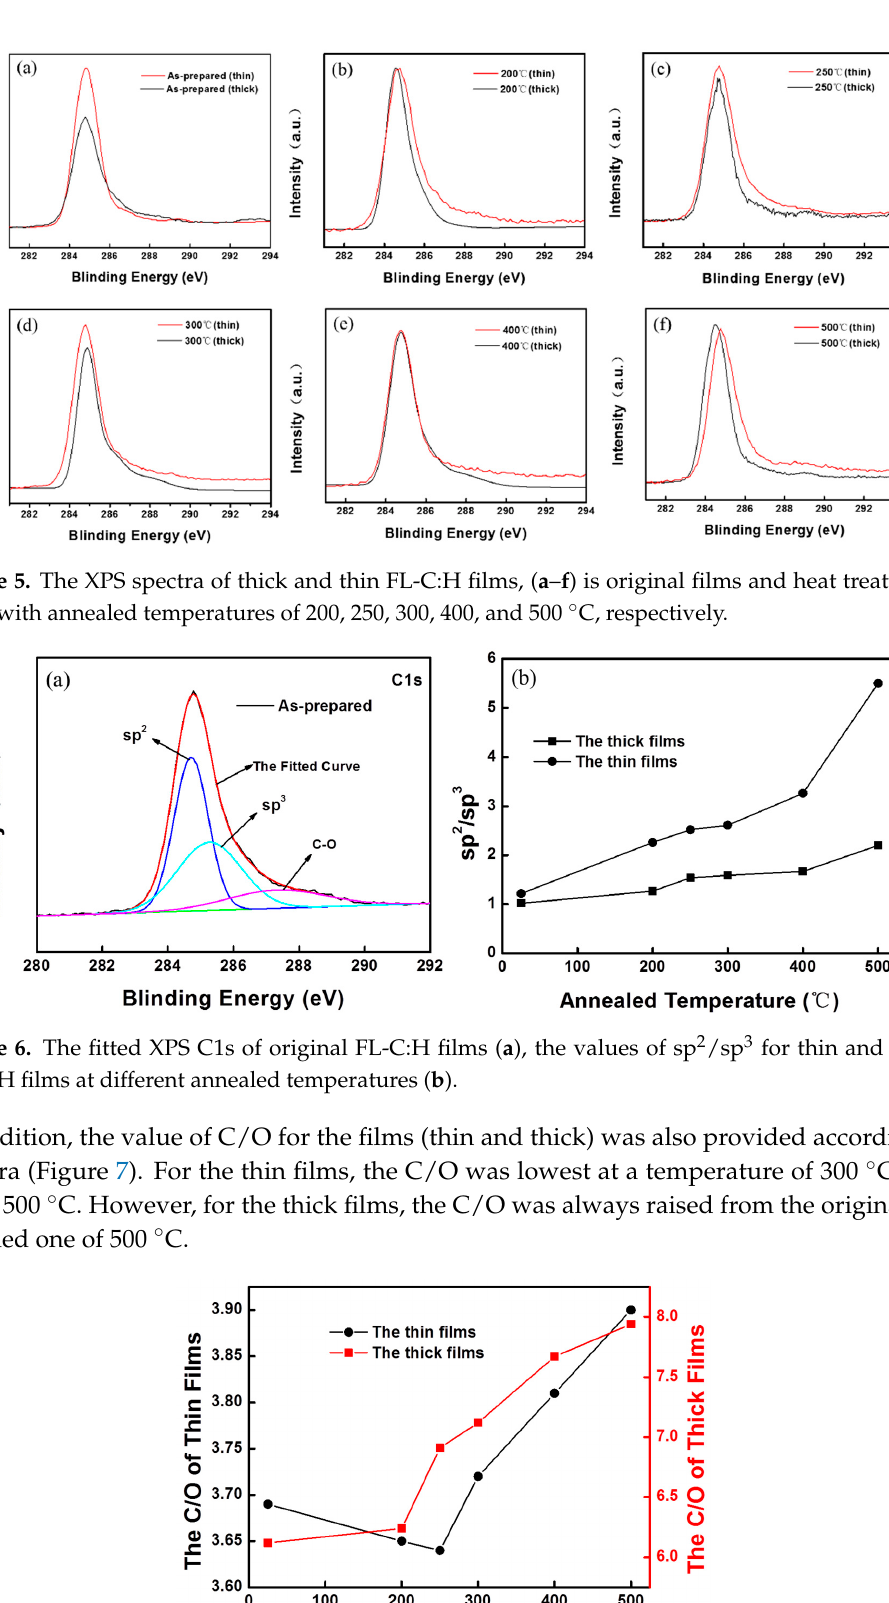
Figure 7 . The value of the C/O for the thin and thick films at different annealed temperature.